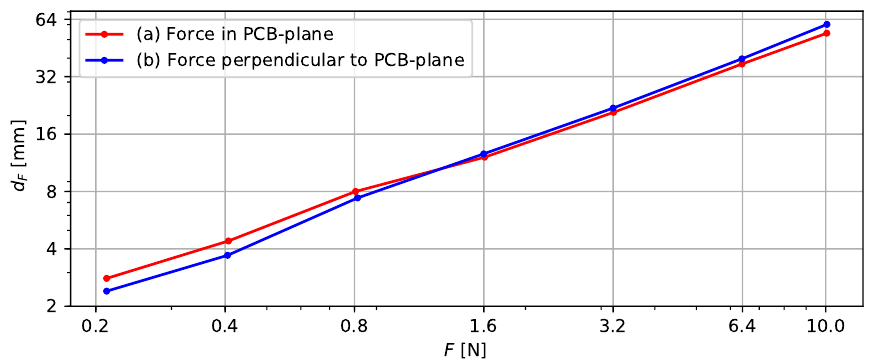
Figure 8. Deformation d F of a 200 mm long probe segment as a result of a sideways force F , either (a) in the PCB plane or (b) perpendicular to the PCB